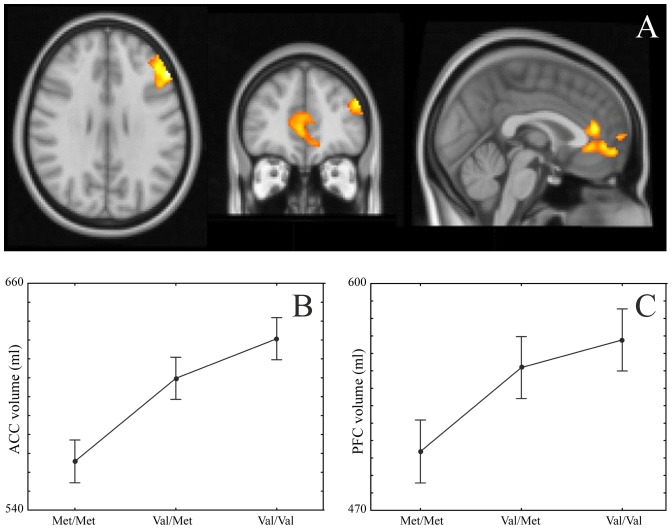
Anterior cingulate and prefrontal cortex grey matter volumes.Panel A: Met/Met vs Val/Val contrast. Significant cluster are rendered onto an average brain in MNI standard space. Panel B: Extracted anterior cingulate grey matter volume for each group. Panel C: Extracted prefrontal cortex (left) grey matter volume for each group. Bars represent standard error.